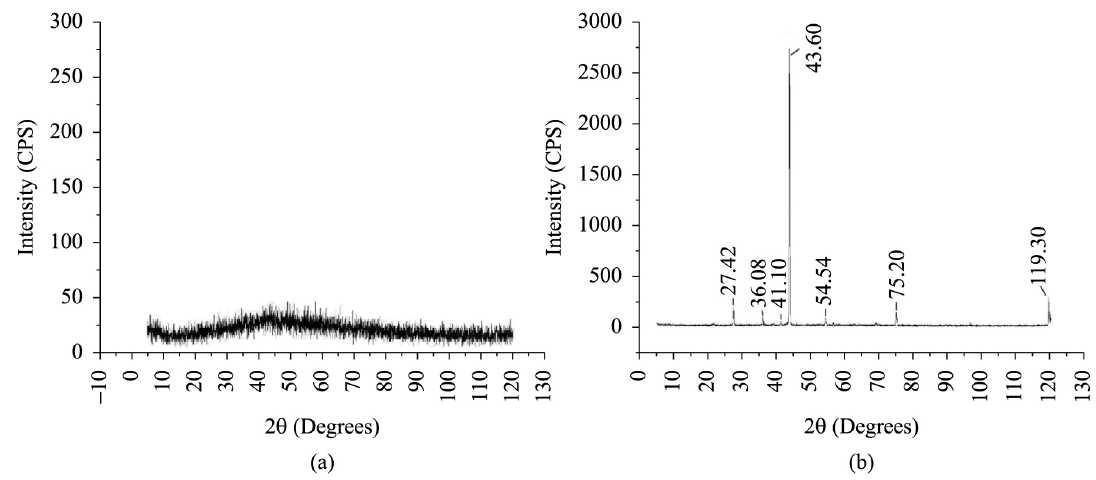
Figure 11. Diffractogram of (a) uncoated diamonds and (b) Ti-coated diamonds, after heat treatment during 360